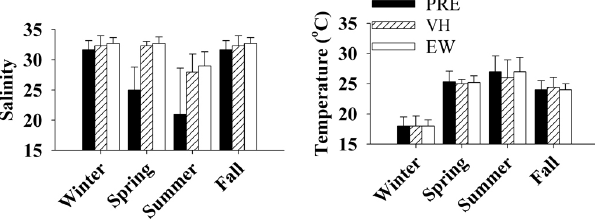
Fig. 2. Seasonal average surface salinity and temperature at S1 to S2 (Pearl River estuary, PRE), S3 to S6 (Victoria Harbor, VH) and S7 to S8 (eastern waters, EW) during 2005 and 2006. Salinity and temperature data are obtained from Hong Kong Environmental Pro- tection Department. Error bars =± 1SD and n = 4 to 12.